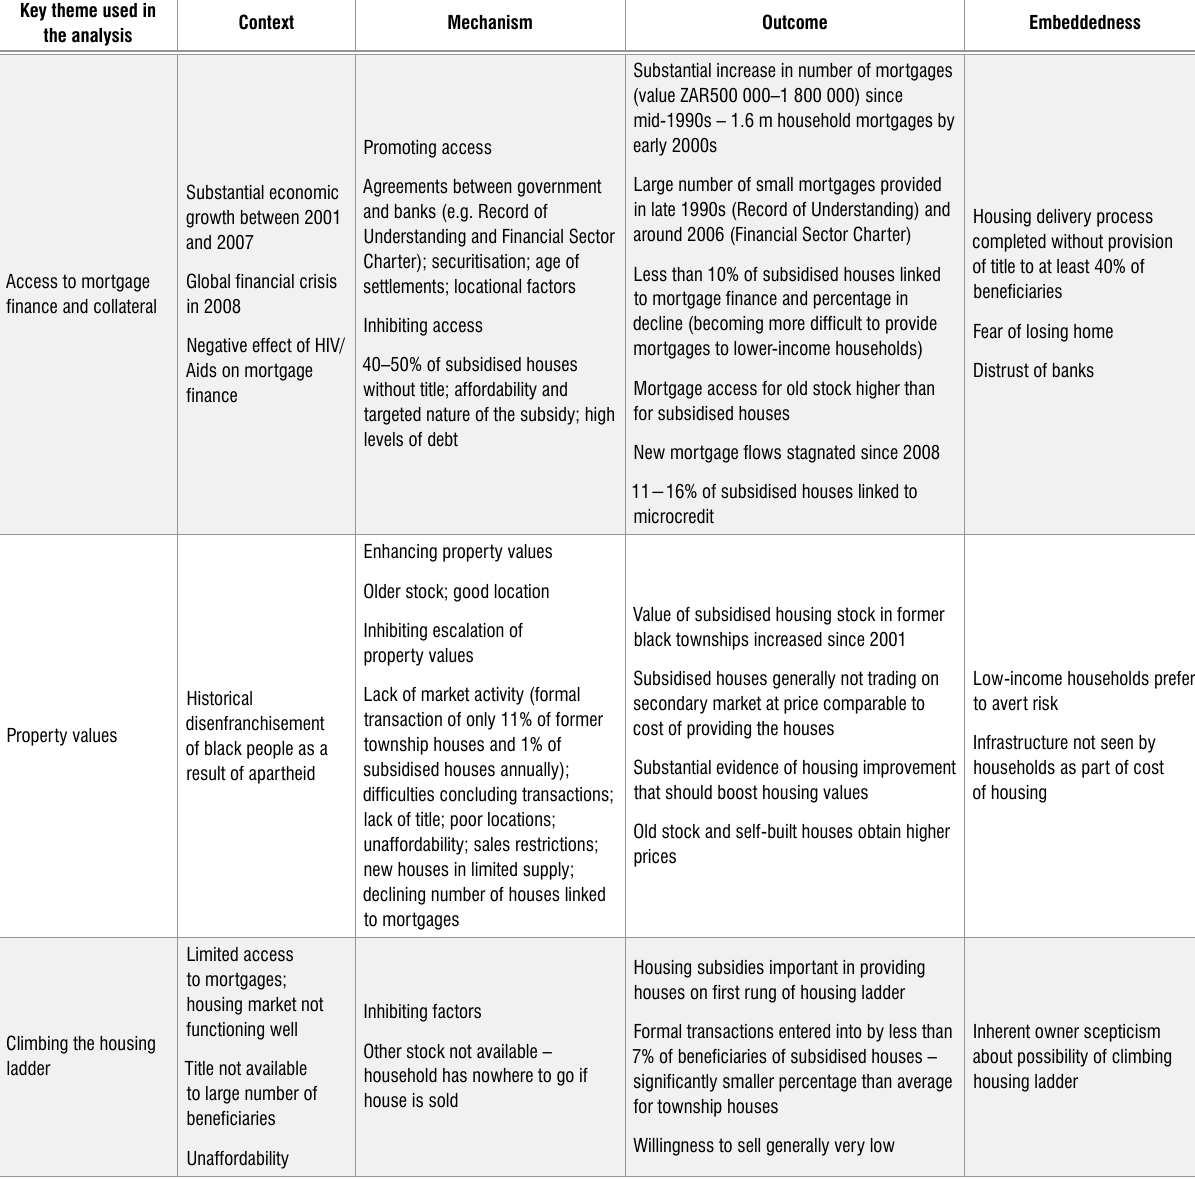
Overview of the main findings within the review framework Key theme used in the